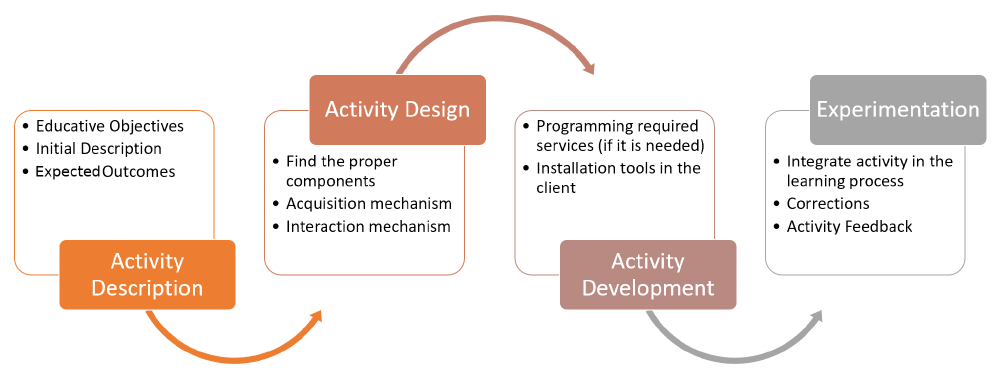
Figure 1. Instructional design phases for a new